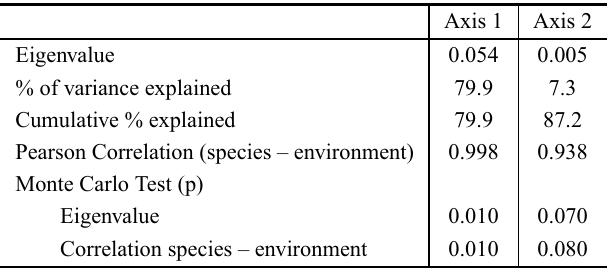
Summary of CCA results for the most representative environ- mental and biological variables in the Carpina reservoir (PE, Brazil) from January to November